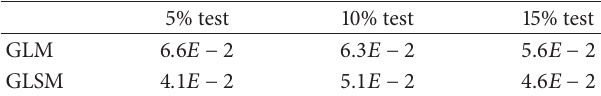
Figure 4: Experimental semivariogram for the GLSM residuals (points), together with the theoretical model fitted according to a nugget effect model (continuous line). Table 4: Error rates for the binary models for three scenarios representing different levels of prediction